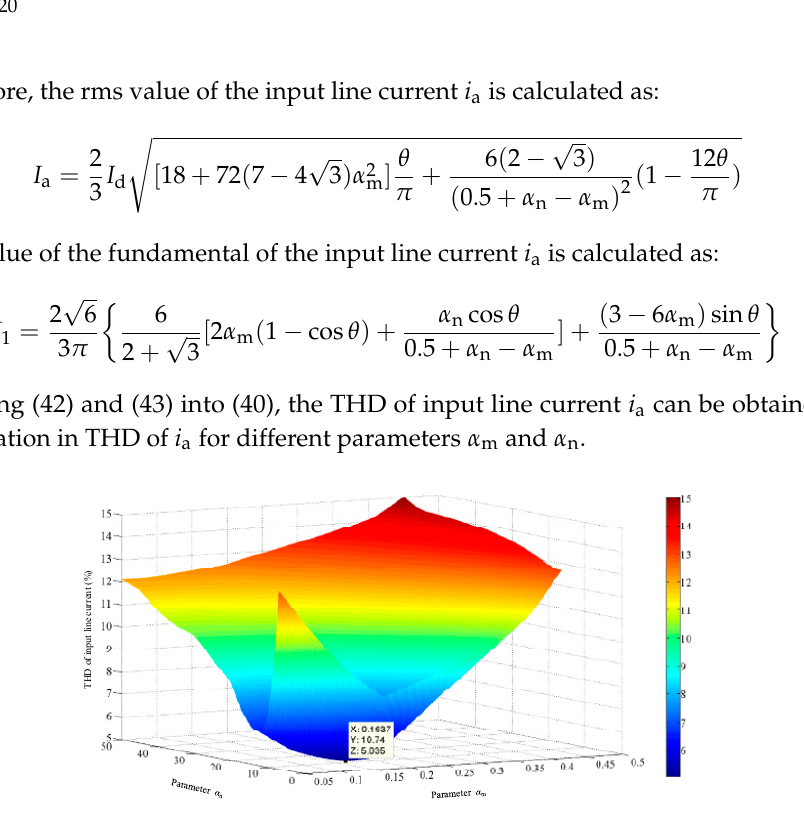
Figure 5. Variation in THD of i a for different parameter α m and α n .